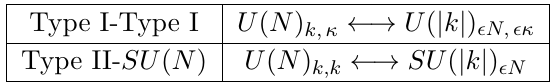
Table 1 . Level rank dualities between pure Chern-Simons theories. The quantity (cid:15) is given by (cid:15) = − sgn ( k ) . Theories on the same row are dual to each other. Here κ = k + sgn( k ) N